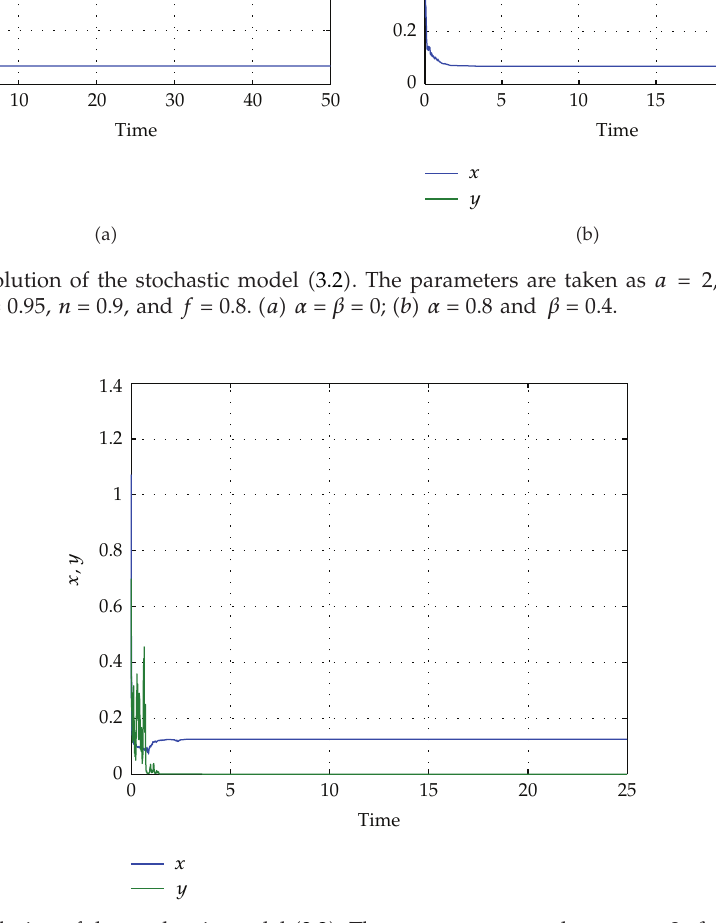
α (cid:6) 0 . 8 , β (cid:6) 0 . 4, starting with a homogeneous state E ∗ (cid:6) (cid:4) 1 . 4761 , 3 . 0326 (cid:5) , the random